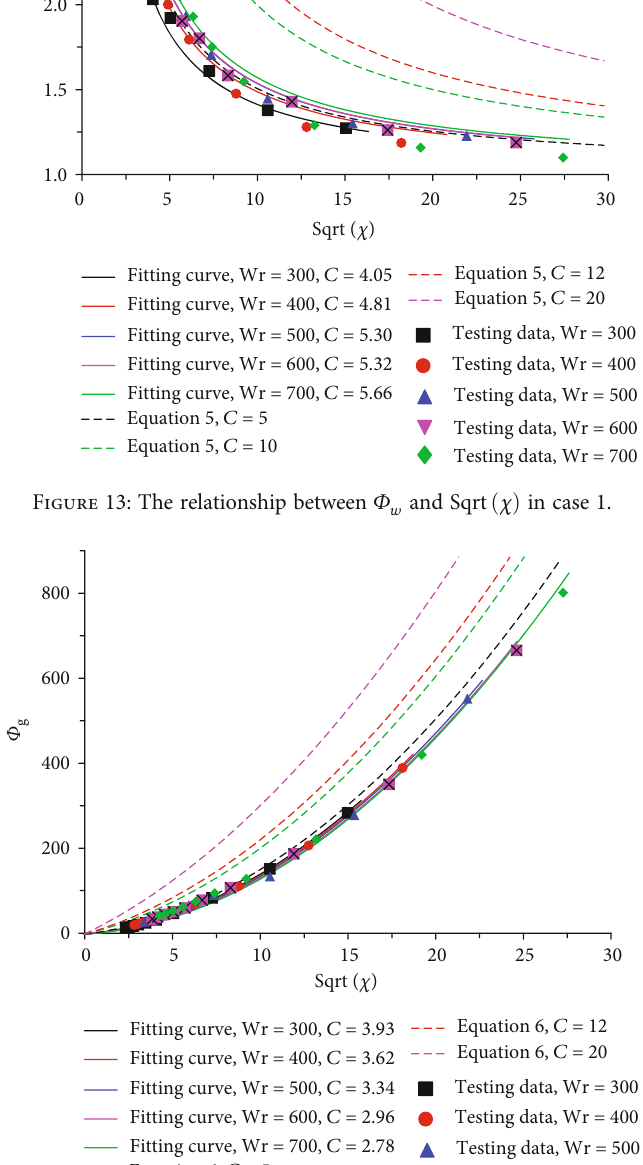
and Sqrt ð χ Þ in case 1. g